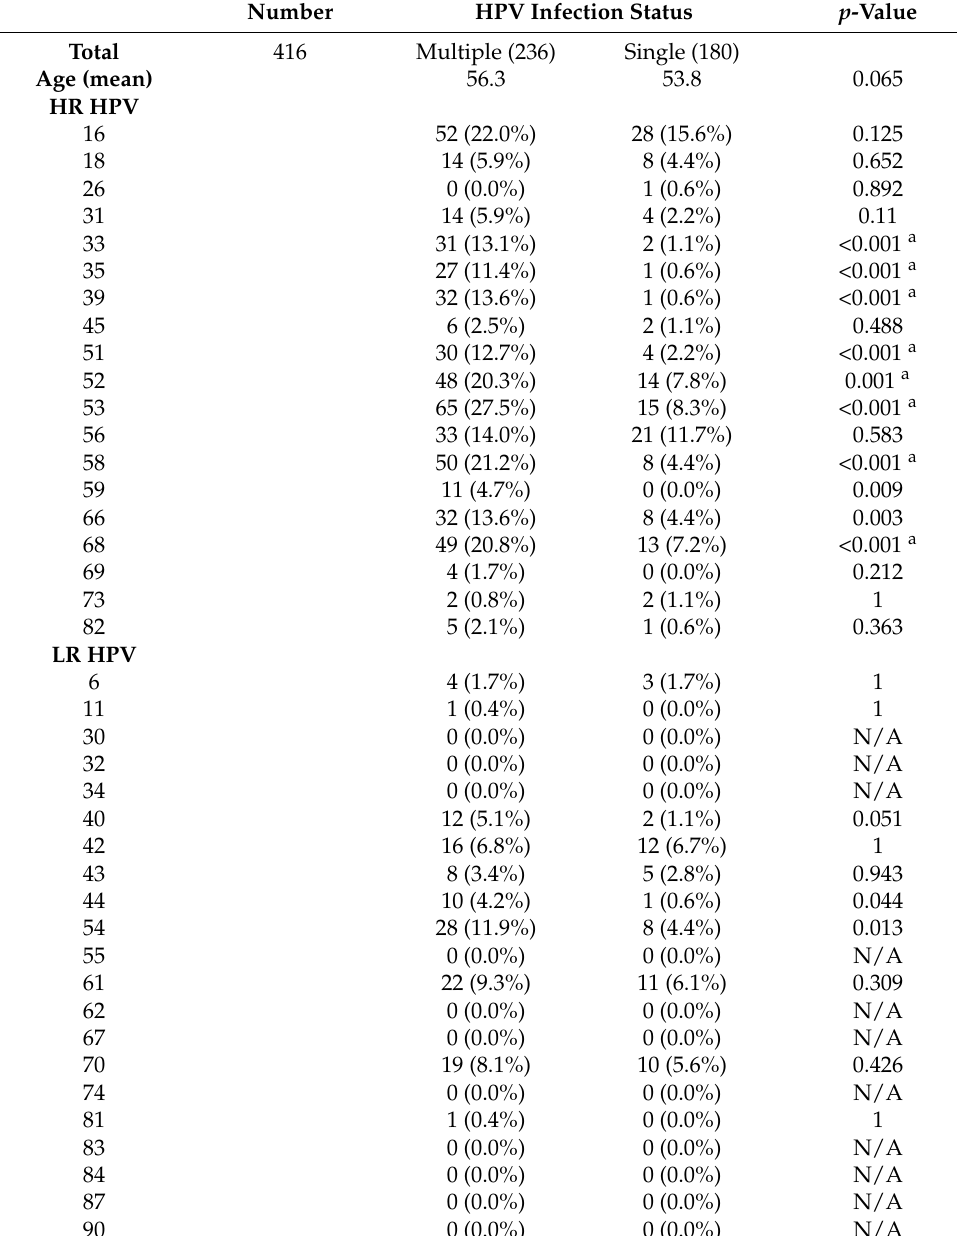
Table 1. Distribution of HPV genotypes (single and multiple